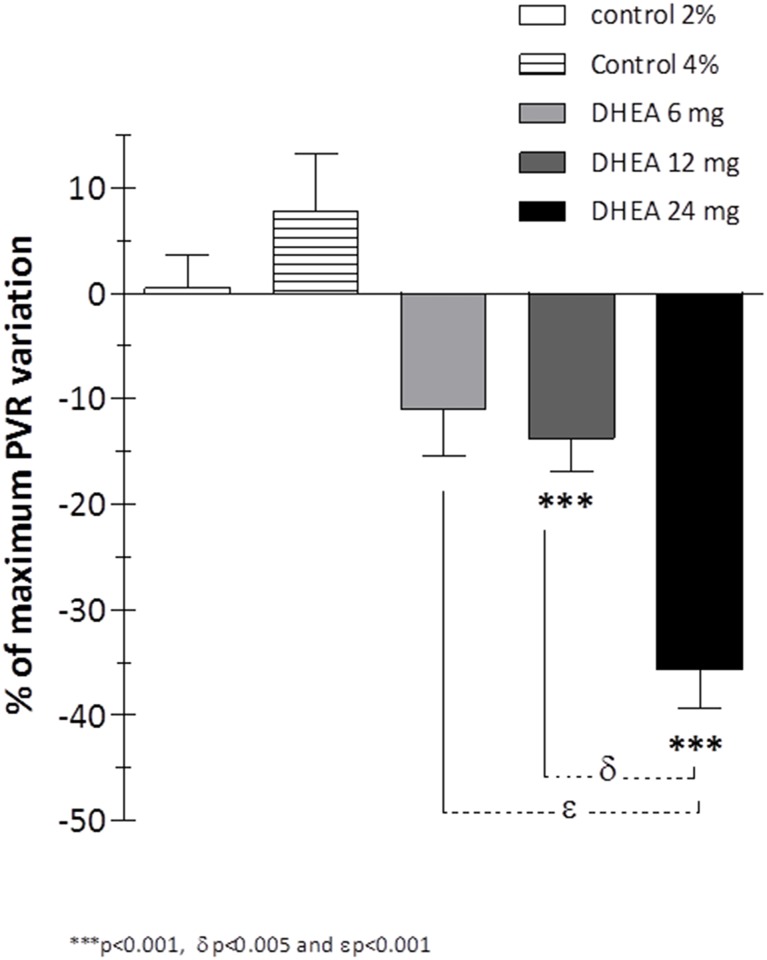
Groups-related changes in PVR with increasing doses of DHEA bolus infusion.Maximum percentage of variation of PVR with increasing doses of DHEA bolus infusion with significant difference in 24 mg DHEA group compared to 6 mg DHEA and to 12 mg DHEA groups (Two-way ANOVA).